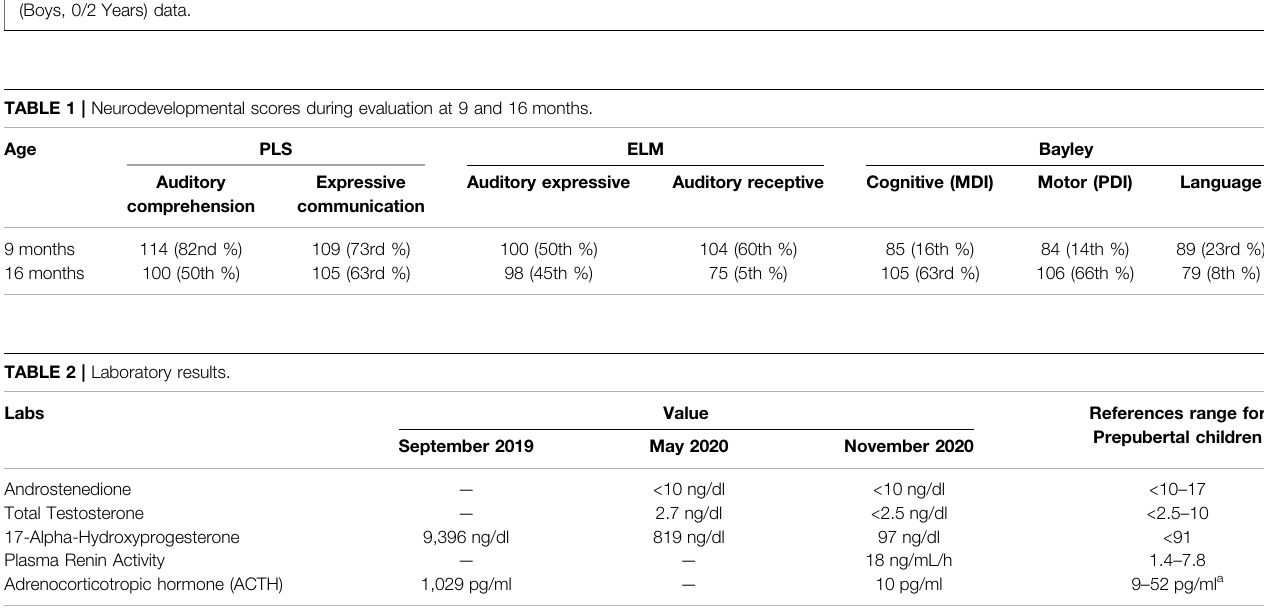
FIGURE 1 | Height and Weight measurements throughout fi rst and second years of life for patient with CAH and 47,XXY. Growth percentages are based on WHO (Boys, 0/2 Years) data.